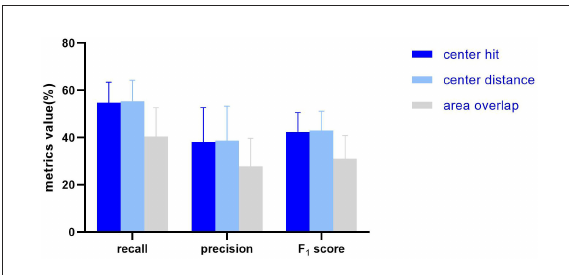
FIGURE3 The histogram showing the average and standard deviation of the recall, precision, F 1 score of the 10 AUTs according to three mark-labeling